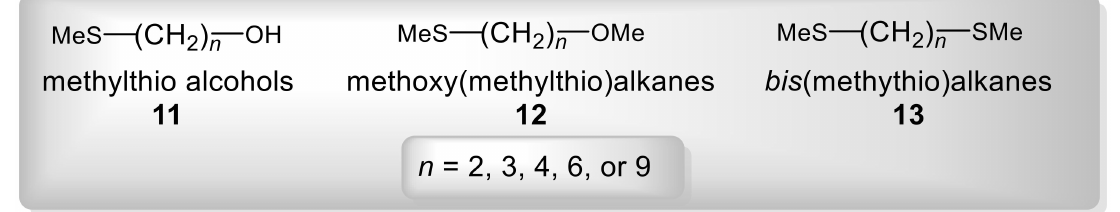
Figure 6. Structures of ω -substituted-1-(methylthio)alkanes 11 – 13 used in the study.